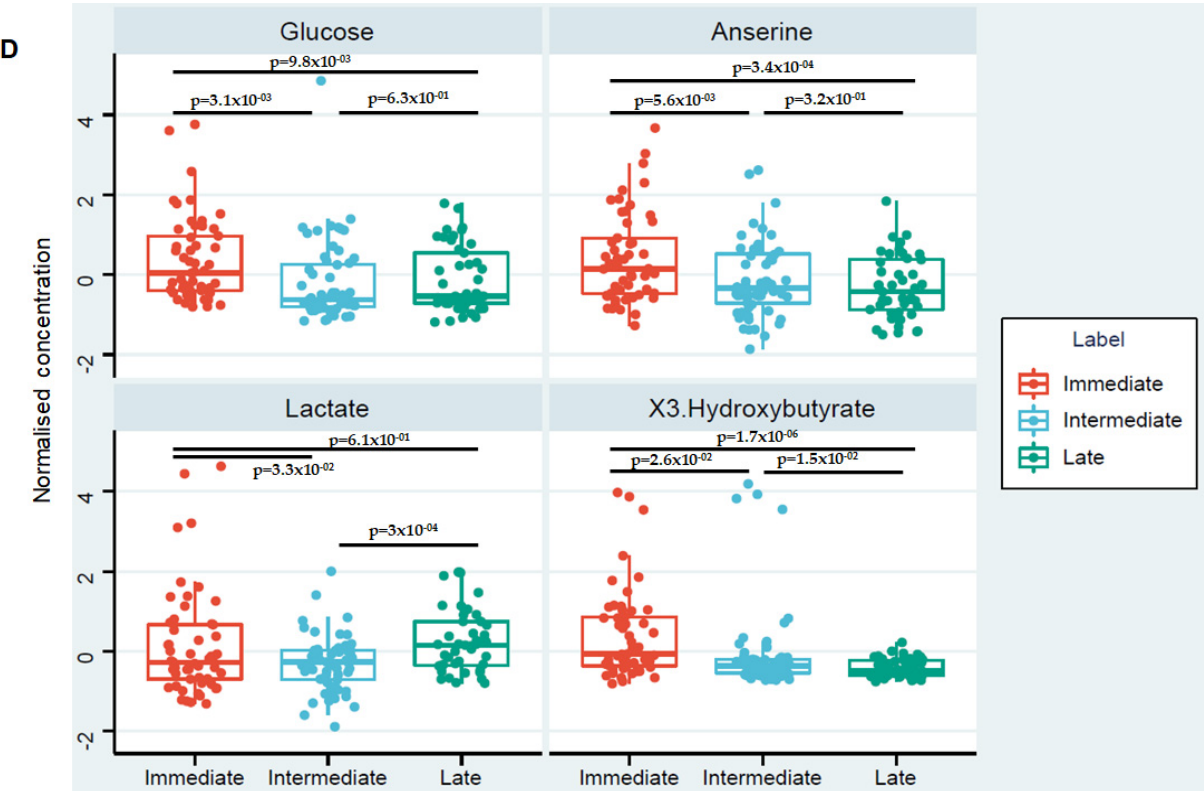
Figure 1. The effect of major traumatic injury on the serum metabolome over time. ( A ) Unsupervised PCA score plot ( B )Supervised PLS-DA score plot analysis of metabolomic data when analysed according to time of sample acquisition. Data are segmented into 3 post-injury phases: acute (red dots), intermediate (green dots) and late (blue dots). Each dot represents a patient. ( C ) Number of significant metabolites unique to each of the post-injury sampling time-points and the number of common metabolites measured at each time segment. ( D ) Box plots showing the differences in the levels of metabolites putatively identified as glucose, anserine, lactate and 3-hydroxybutyrate between the three-time segments.